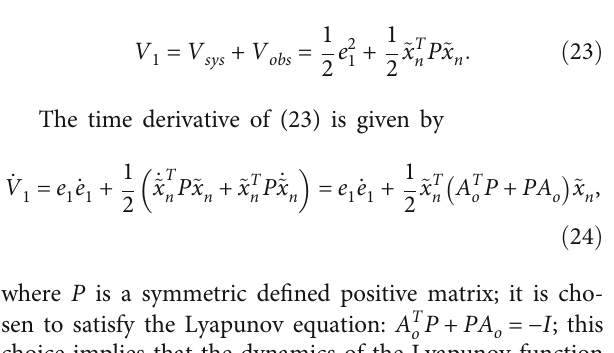
Table 3: Parameters of the grid observer and